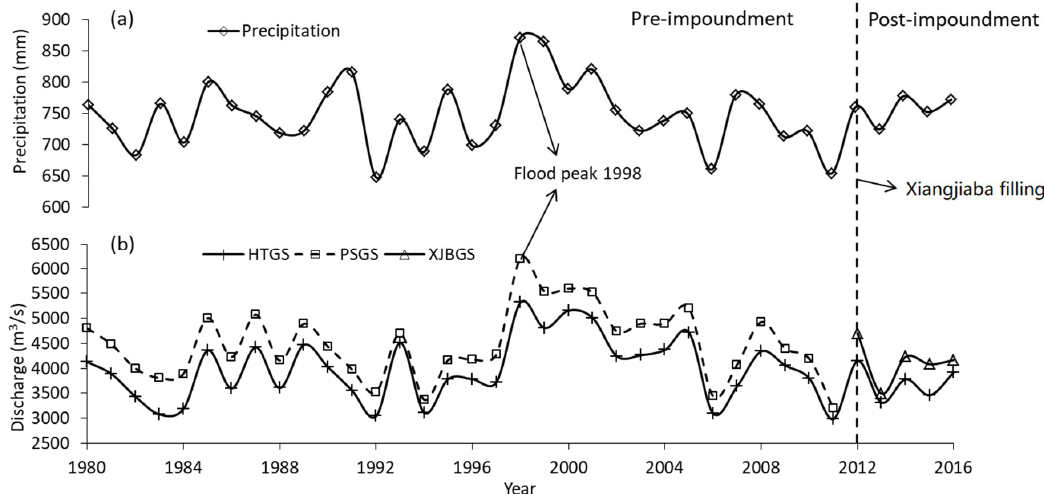
Figure 2. Time series of annual mean precipitation in the Jinsha River basin ( a ) and annual mean discharge ( b ) at gauging stations located upstream (HTGS), and downstream (PSGS, XJBGS) of the two studied reservoirs. The filling of the Xiangjiaba reservoir in 2012 (vertical dashed line) divides the time series into the pre- and post-impoundment periods.